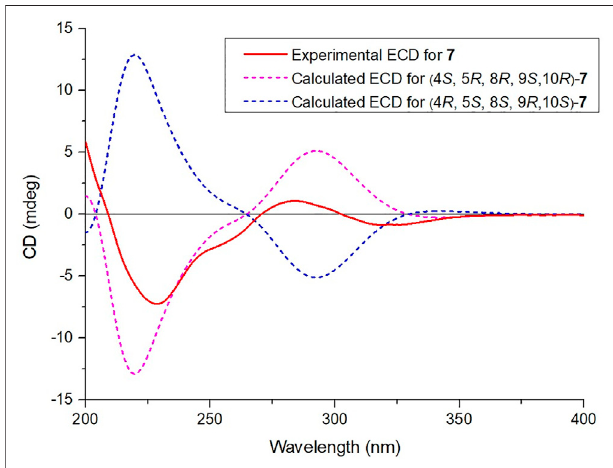
FIGURE 8 | Calculated and experimental ECD spectra of compound 7